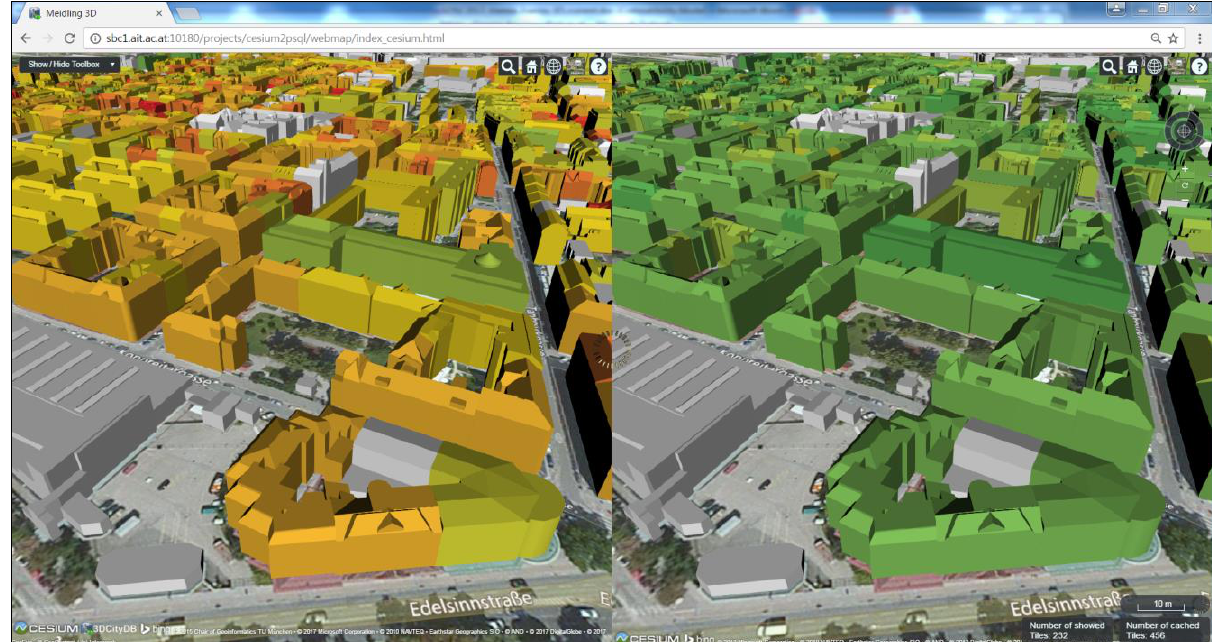
Figure 7. “Twin view” visualisation modus for energy performance scenarios: the current energy performance class of each building [left] can be compared with the corresponding one after a refurbishment has been carried out